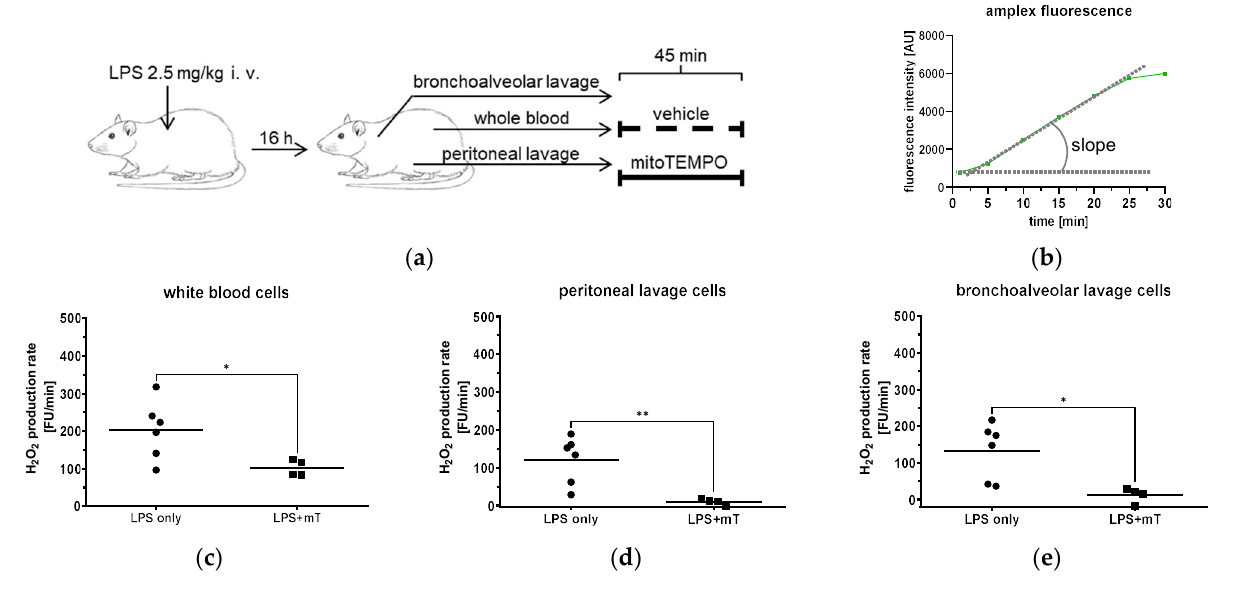
Figure 1. Effect of mitoTEMPO (mT) on generation of ROS in different body compartments of rats. ( a ) Rats were challenged with 2.5 mg/kg body weight lipopolysaccharide (LPS) and biological fluids were withdrawn after 16 h. ( b ) Scheme of H 2 O 2 production rate assessed by Amplex Red by calcu- lating the slope. ( c – e ) Effect of mitoTEMPO on H 2 O 2 production rate of white blood cells ( c ), perito- neal lavage ( d ), and bronchoalveolar lavage ( e ). Unpaired t -test, * p < 0.05, ** p < 0.01. For bronchoalveolar lavage, we used a protocol adapted from [19]. Briefly, a 19-gauge (PBS) and 10% fetal bovine serum (FBS) were administered and aspirated slowly through tria) and kept on ice. The procedure was repeated four times.